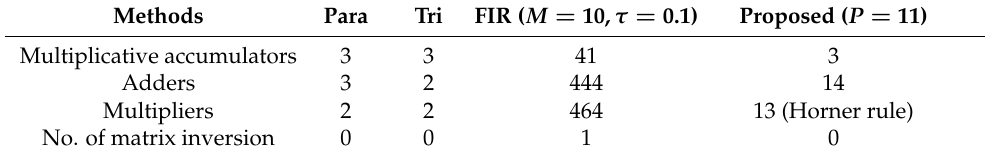
Table 2. Computational complexity comparison with existing approaches.